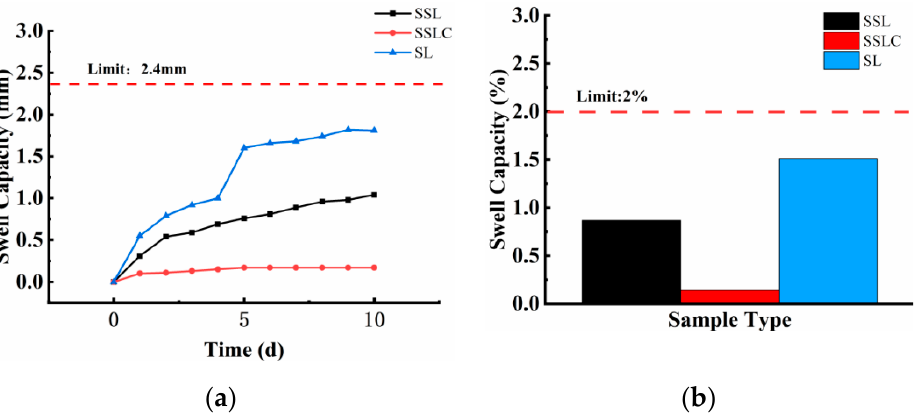
Figure 12. The volume stability test results: ( a ) volume expansion curve; ( b ) final volume expansion rate.